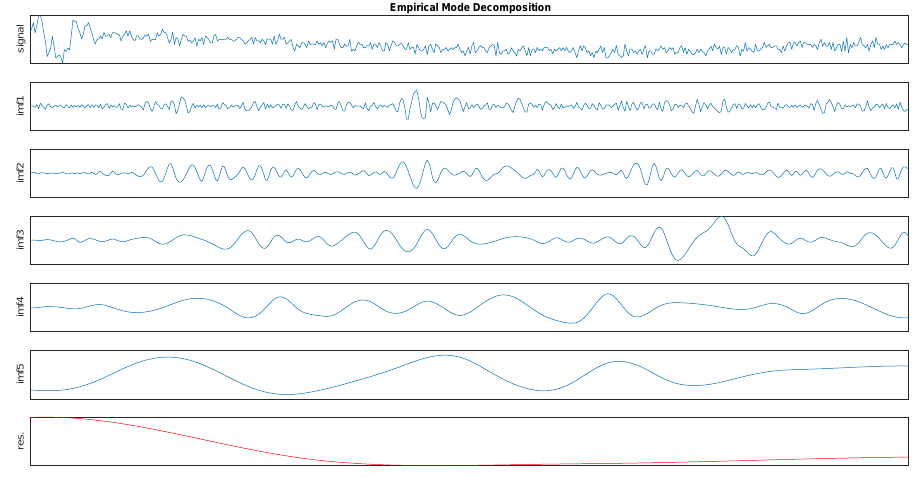
Figure 2. The empirical mode decomposition (EMD) components from the activity data. Notice that the first one is the raw data and the last component plotted by red line is a trend instead of an